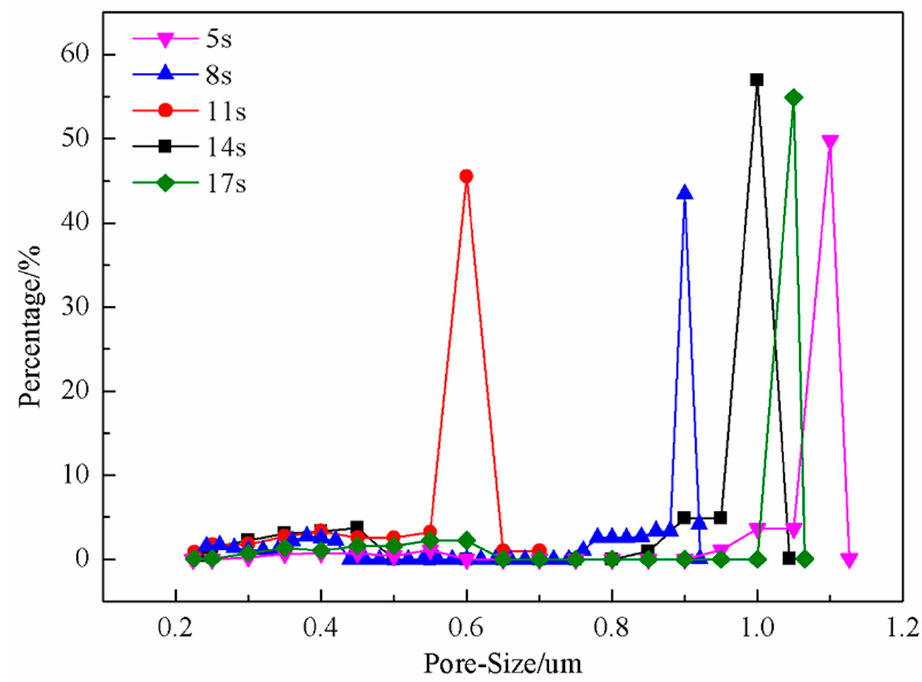
Figure 7. Pore-size distribution of the ceramic membrane with different coating times.